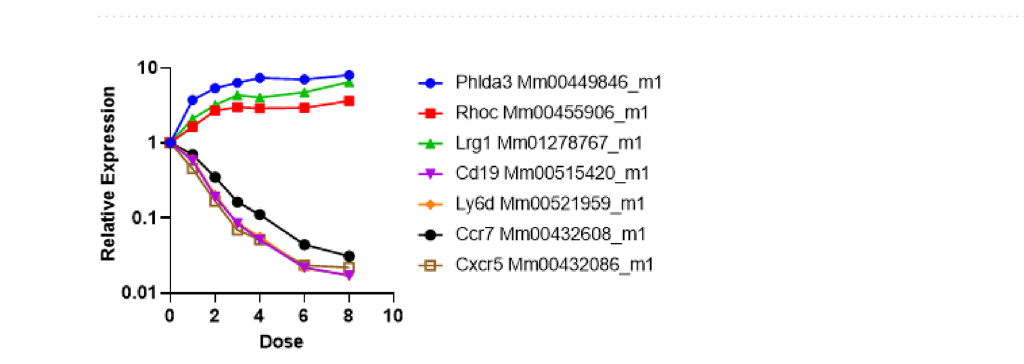
Figure 4. Blood cell counts from flow cytometry analysis in an independent mouse cohort. ( A ) Leucocytes (CD45 + cells)/µL of blood, ( B ) B cells (CD19 +)/µL of blood, ( C ) T cells (CD3e +)/µL of blood; and ( D ) Myeloid cells/µL of blood are plotted with dose as the independent variable. All doses of irradiation produce a significant change of T and B cell numbers compared to control levels; however, B cells are more sensitive. 5 males and 5 females were used for this analysis and data is combined, as there were no differences by sex. ( p values are indicated in the figure as * p < 0.05).